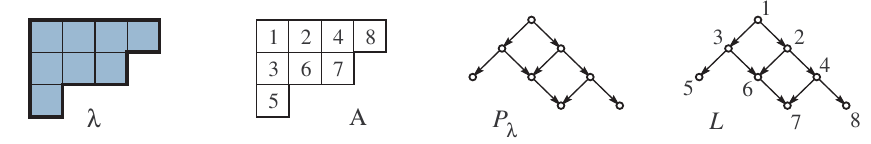
Figure 1.1: Young diagram λ = ( 4 , 3 , 1 ) , standard Young tableau A ∈ SYT ( λ ) , poset P linear extension L ∈ L ( P